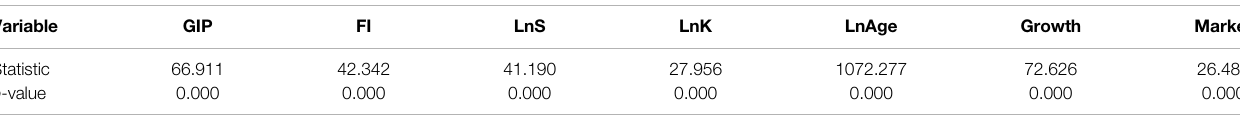
TABLE 3 | Unit test on ADF- fi sher test.